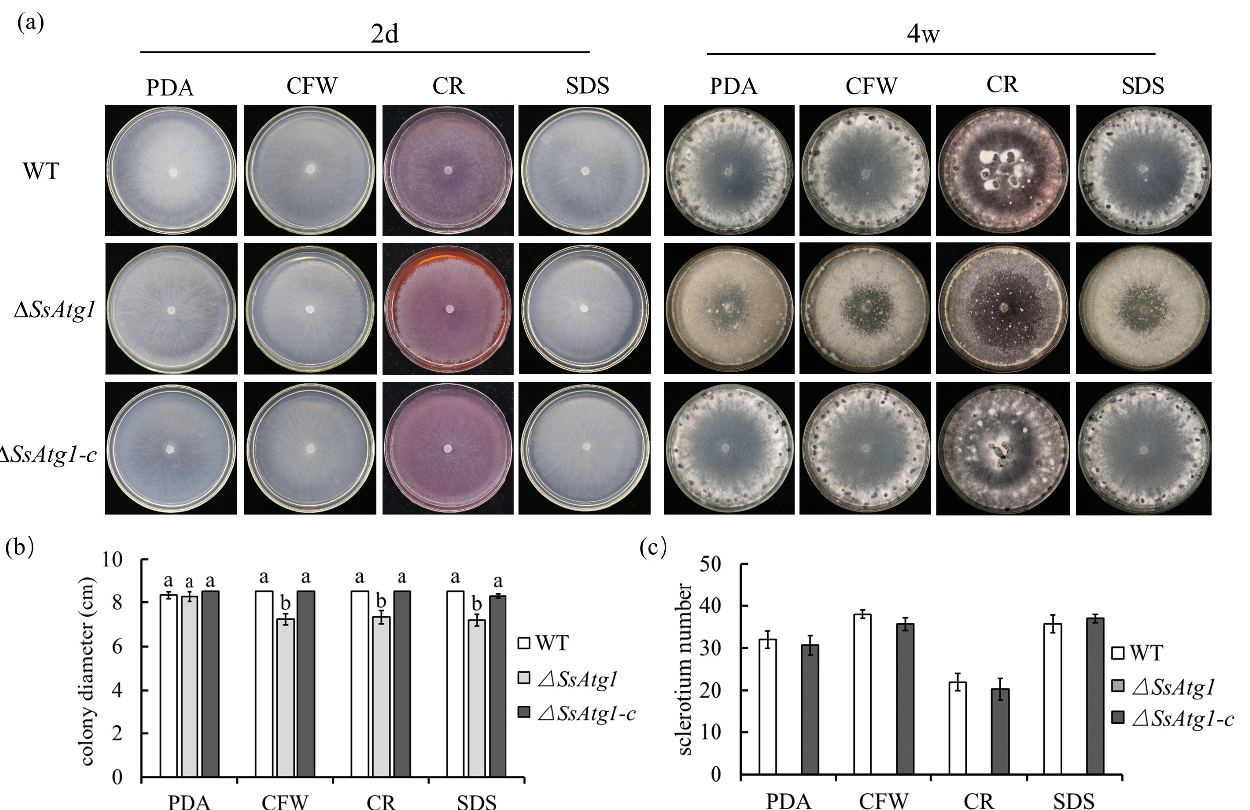
Figure 5. ∆ SsAtg1 is sensitive to cell wall synthesis inhibitors. ( a , b ) Colony diameter and morphology of wild type, ∆ SsAtg1 and the genetically complemented strain. Strains were inoculated on PDA supplemented with CFW, CR and SDS and colony diameters were measured by the cross method at 48 h. ( c ) Quantification of sclerotia development in response to cell wall synthesis inhibitors. Colony morphology and sclerotia number were recorded after 4 weeks. The letters indicated significant differences (p < 0.05), error bars represent standard deviation from the mean.